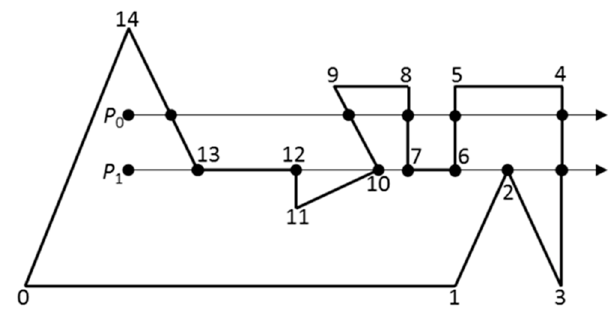
Figure 5. Point-in-polygon test by counting intersections of ray with polygon. The ray for point P 0 only crosses edges transversely. The number of crossings is odd (5), so the point is inside the polygon. The ray for point P 1 is more complex to analyze (redrawn according to [34]).